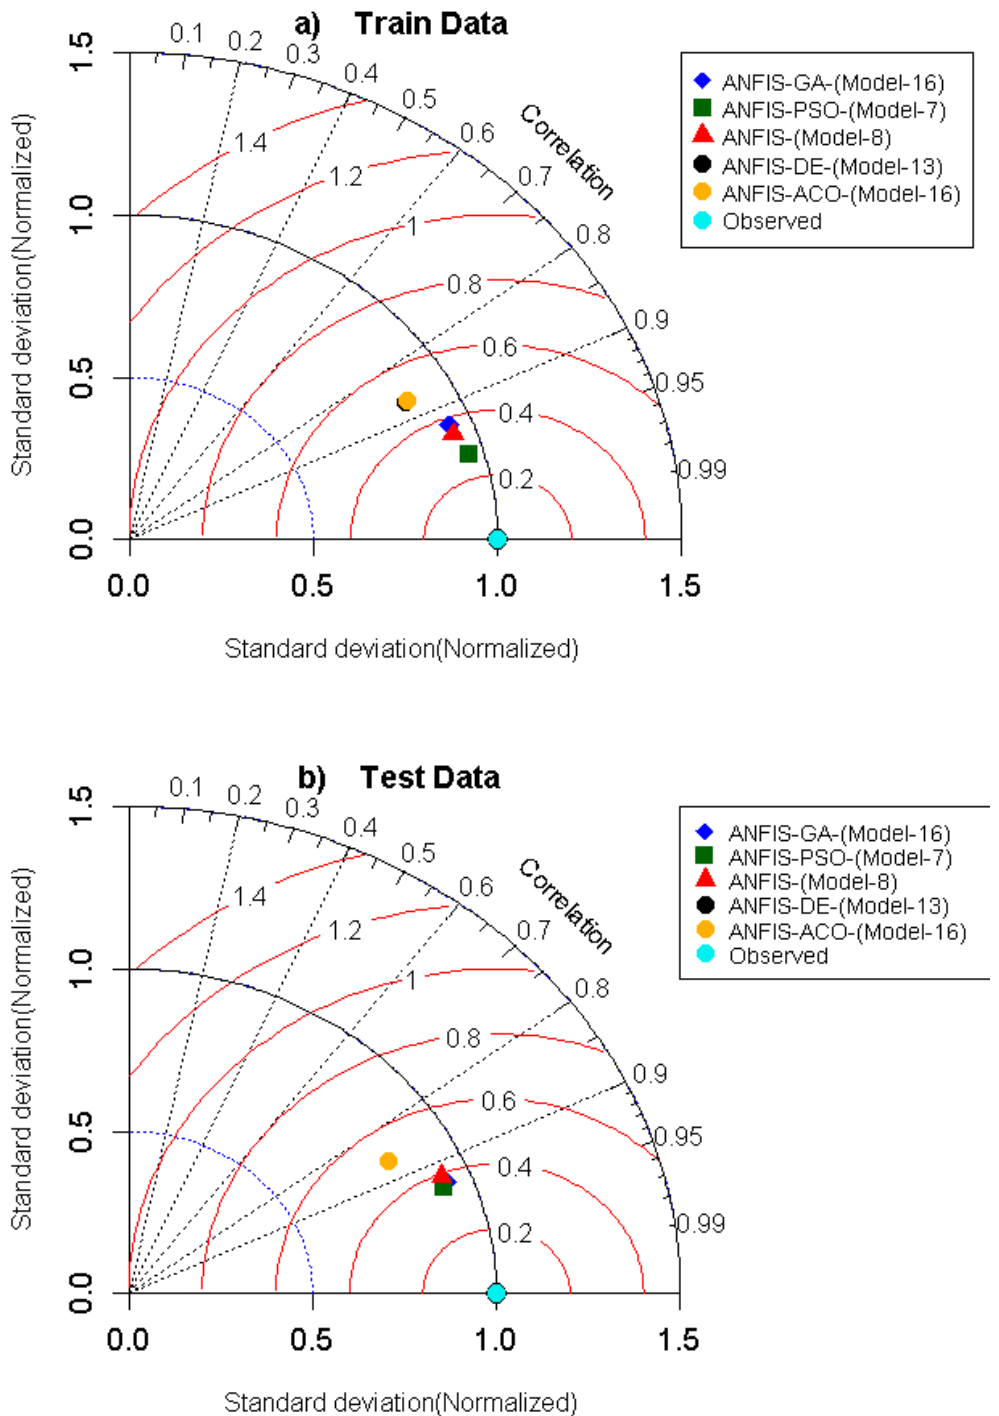
Figure 6. Normalized Taylor diagrams of predicted and observed standardized shear strength: ( a ) Training stage and ( b ) Testing stage.